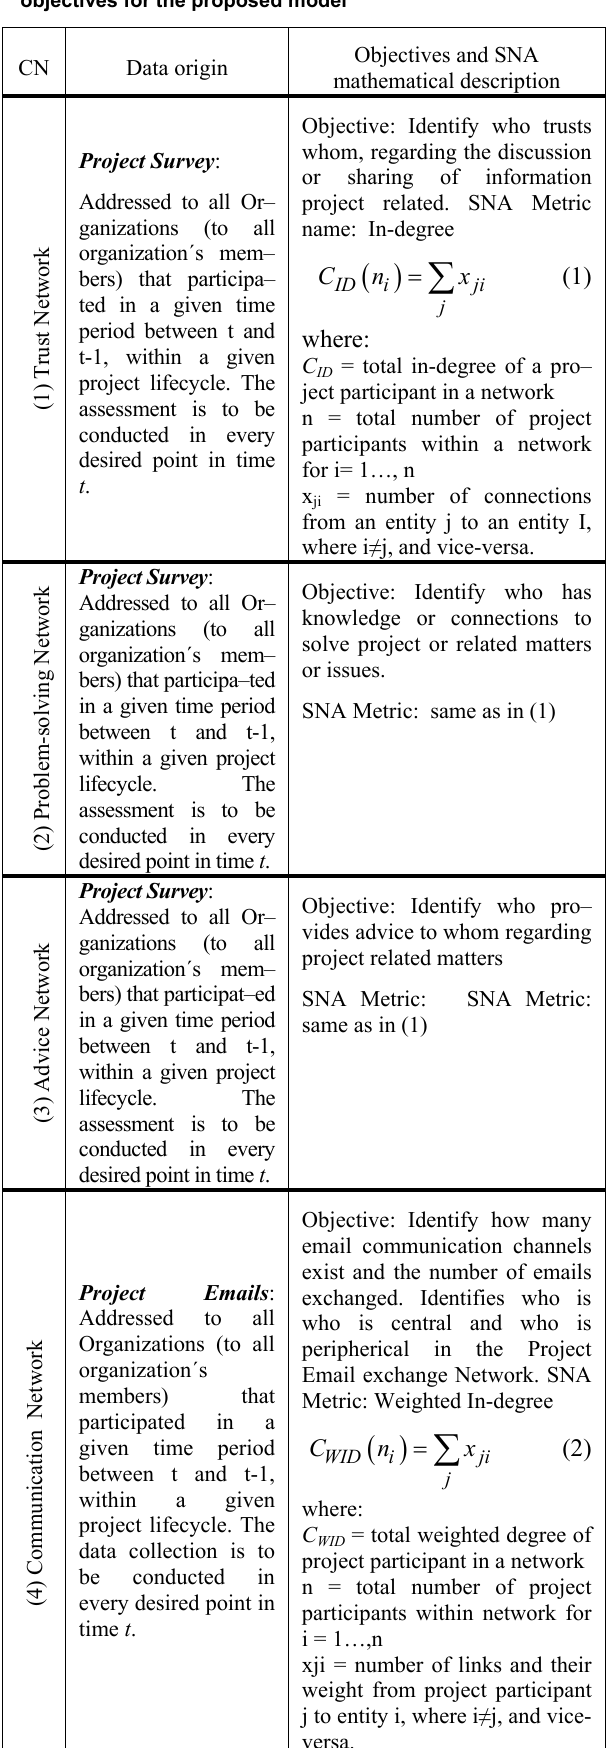
Table 3. Social Network Analysis centrality metrics and objectives for the proposed